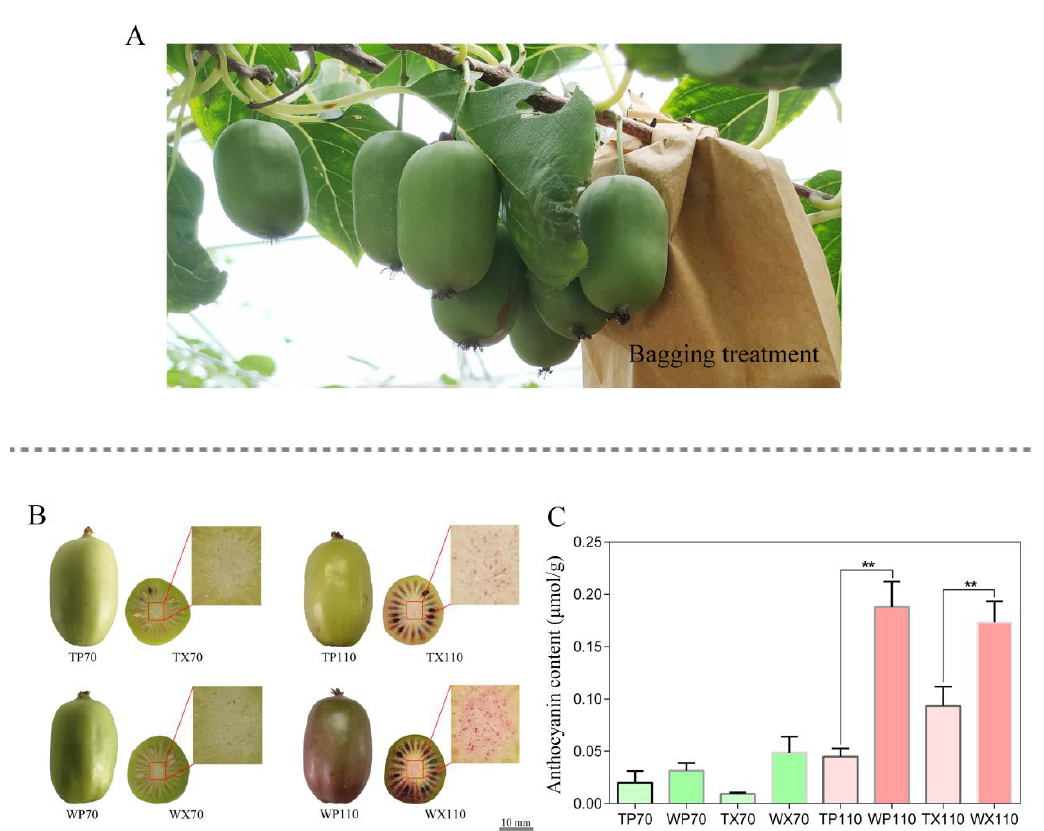
Figure 1. Sample treatment and preparation for RNA-seq. ( A ) Fruits were bagged using two-layer light-impermeable paper bags at one month after full bloom. ( B ) Peel and core were collected from bagged and unbagged fruit making a total of eight typed samples used for RNA-seq. ( C ) The anthocyanin content of these eight typed samples. Note: S1—fruit stage at 70 days after full bloom, S2—fruit stage at 110 days after full bloom, TP70—peel from bagged fruit at S1, TX70—core from bagged fruit at S1, TP110—peel from bagged fruit at S2, TX110—core from bagged fruit at S2, WP70—peel from unbagged fruit at S1, WX70—core from unbagged fruit at S1, WP110—peel from unbagged fruit at S2, WX110—core from unbagged fruit at S2. Data were analyzed with Student ’ s t-test ( ** p < 0.01).